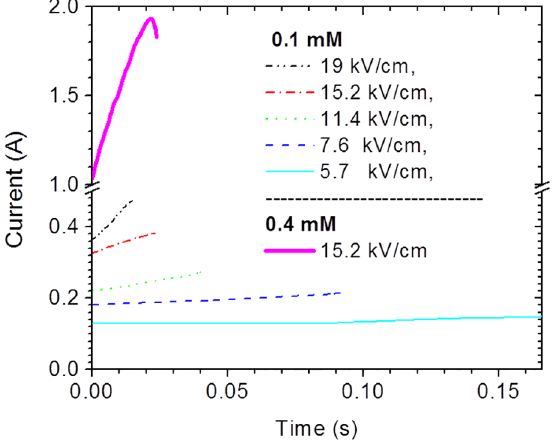
operated under different applied voltages. Bipolar square pulses with different pulse amplitudes, V A , and pulse train durations, t , were applied to a lysis chamber containing a cell suspension with ionic strength of 0.1 mM and the current envelopes were measured. Also presented is the current envelope for the case of V A =152 V applied to a cell suspension having ionic strength of 0.4 mM. The suspension in this case reaches boiling temperature prior to the end of the pulse train.